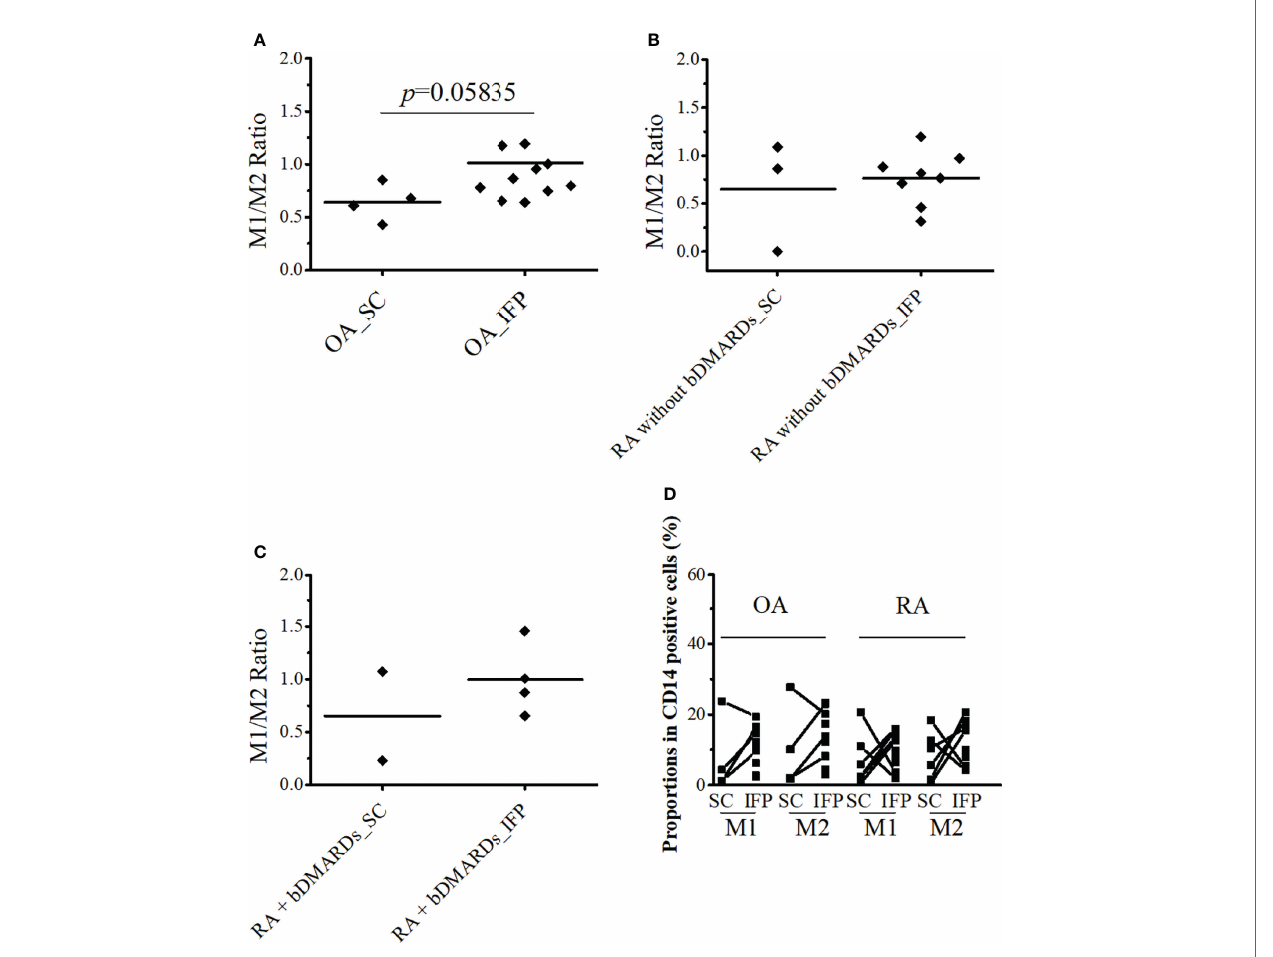
FIGURE 3 | CD14 ++ CD80 + and CD14 ++ CD163 + cell ratio increases by 1.36-fold in osteoarthritis (OA) infrapatellar fat pads (IFP). (A – C) Ratio of CD14 ++ CD80 + /CD14 + + CD163 + cells in the infrapatellar fat pads (IFP) and subcutaneous fat tissues (SC) from the OA, rheumatoid arthritis (RA) without bDMARDs, and RA treated with bDMARDs groups. To calculate ratios and proportions, adipose-resident CD14-positive cells were stained with anti-human CD80, CD163, and CD14 antibodies and evaluated using fl ow cytometry. (D) Proportions of CD14 ++ CD80 + and CD14 ++ CD163 + cells in the SC and IFP tissues of OA and RA patients (SC OA, n = 4; SC RA, n = 6; IFP OA, n = 11; IFP RA, n = 13). The x-axis displays samples from IFP and SC grouped by OA and RA, and the y-axis displays the proportions of CD14 ++ CD80 + cells or CD14 ++ CD163 + cells in CD14-positive cells. Lines connecting the dots between SC and IFP indicate samples from the same patients. Gating strategies for obtaining CD14 ++ CD80 + cells and CD14 ++ CD163 + cells as well as fl uorescence minus one are presented in Supplementary Figures S1 and S2 . Statistics were calculated by the paired-sample Wilcoxon signed-rank test between CD14 ++ CD80 + and CD14 ++ CD163 + cells from the same patients. The Mann – Whitney U -test was used for analysis between different groups.